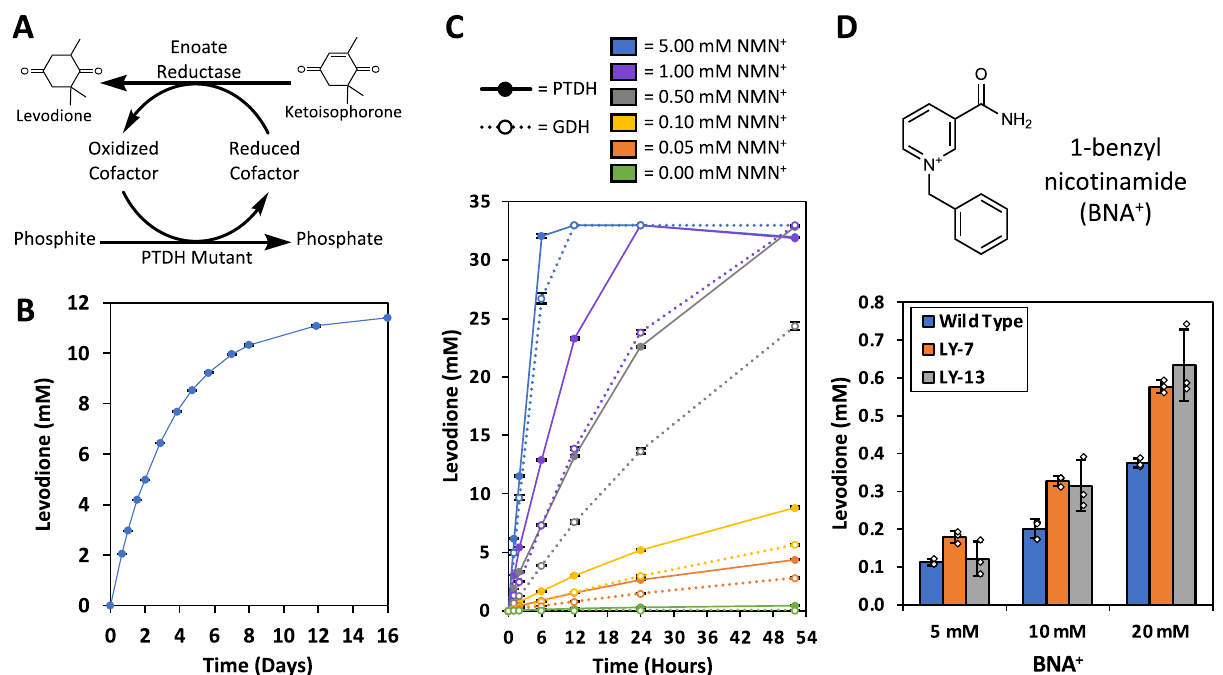
Fig. 4 | Applying TS-PTDH to reductive biotransformation. A A redox cofactor cycling system was constructed using PTDH as a reduced cofactor regeneration source. B ReactionprogressioncurvefordeterminingtheTTNofLY-13intheredox cyclingsystememployingNMN(H).AlowconcentrationofLY-13,0.25 µ M,requires highproteinturnovertoenablethereactiontoprogress. C ComparisonofusingLY- 13 or an NMNH-active glucose dehydrogenase (GDH Triple) as NMNH recycling enzymes.10 µ MLY-13orGDHTripleweresuppliedtothecyclingsystemcontaining